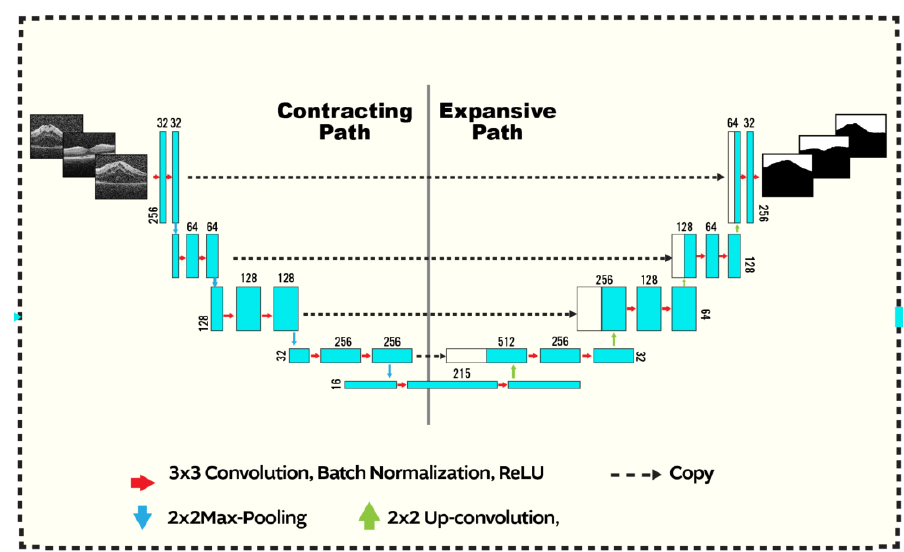
Figure 2. U-CNN structure: The input is a fused image of size 256 × 256 produced as shown in Figure 1. The segmented output has the same dimensions as the input. Convolution (with a 3 × 3 kernel), max-pooling, up-convolution operations are respectively indicted using the blue, red, and green arrows. The max-pooling (up-convolution) operation decreases (increases) the spatial dimensions by a factor of 2. The first path starts with 32 kernels and increases up to 512, where it decreases from 512 to 1 in the second. Zero-padding is employed at the boundaries. Copied contextual information afrom the contracting branch are concatenated to the expansive path (dashed